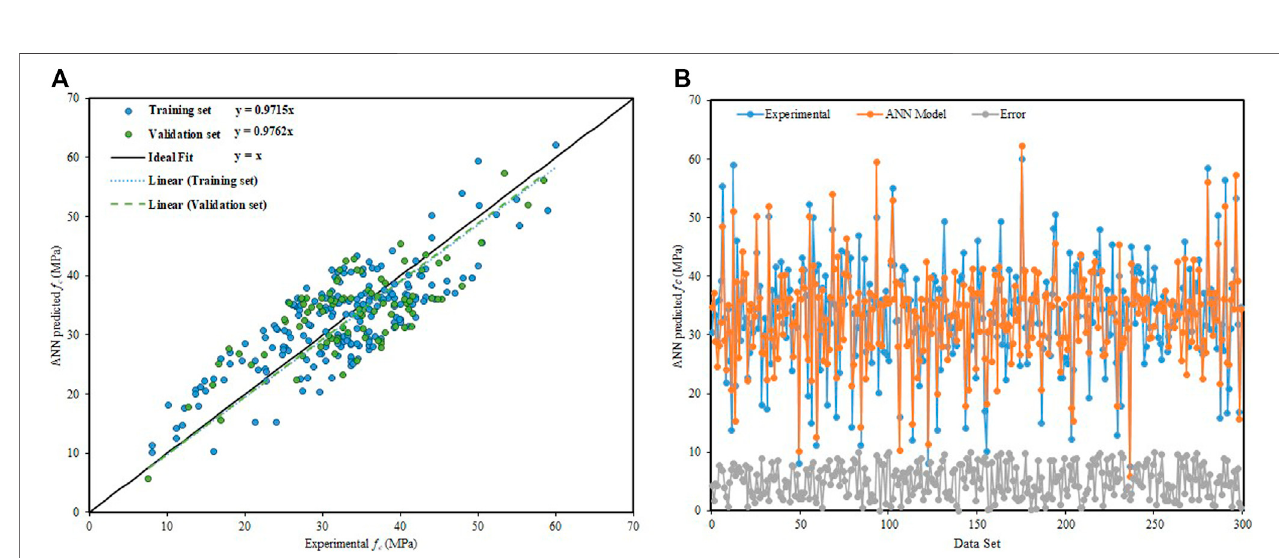
FIGURE 5 | ANN model predictive results. (A) Regression line slope of the ANN model. (B) Dispersion of absolute error values of the ANN model.